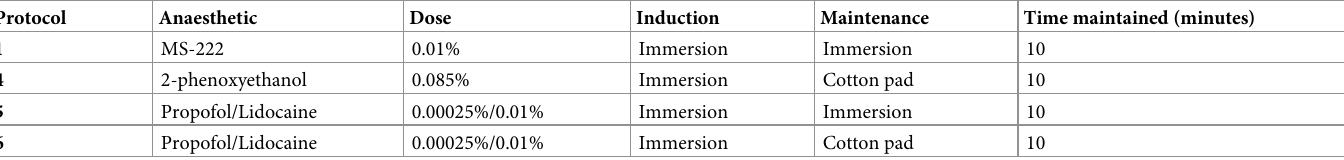
Table 2. Protocol numbers and the corresponding